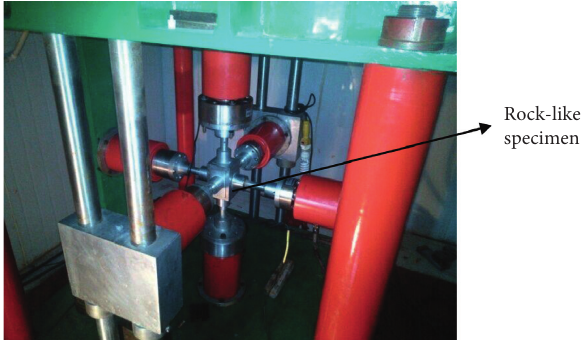
Figure 9: The triaxial loading machine for rock-like specimen.